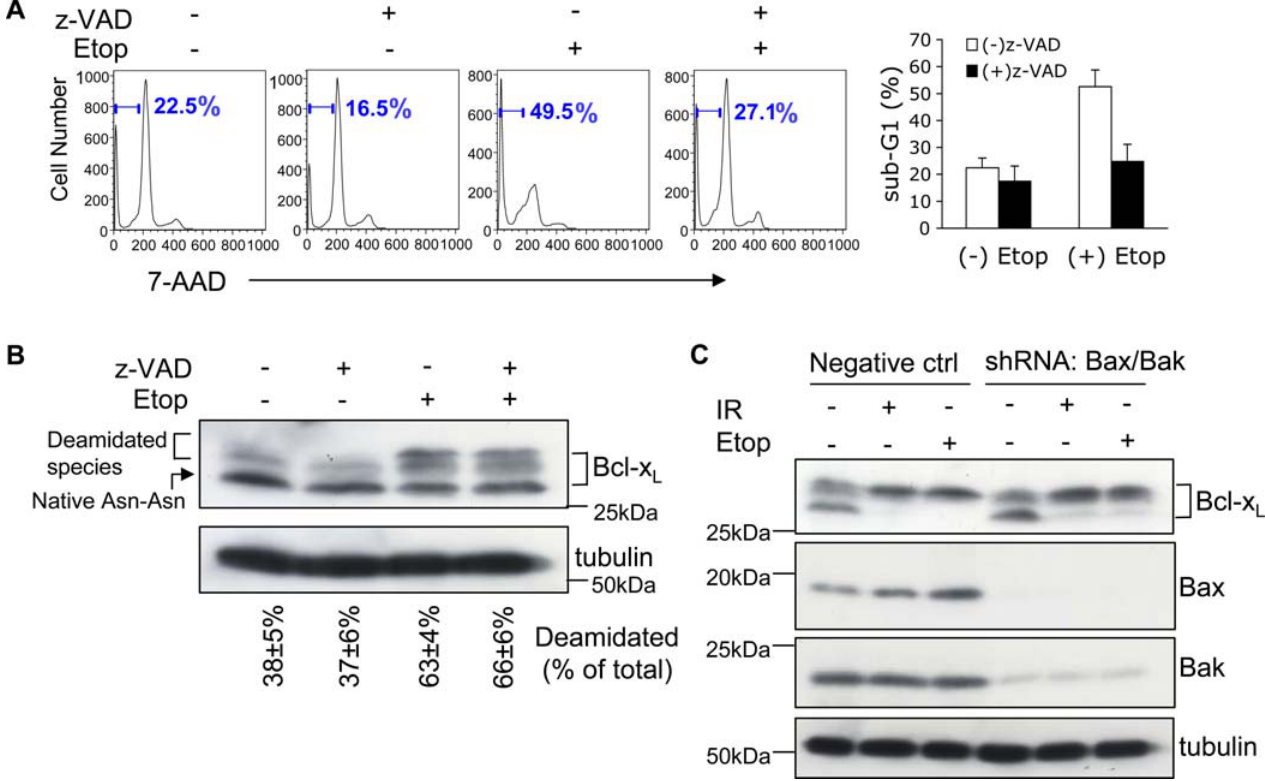
Figure 1. DNA Damage–Induced Bcl-x L Deamidation Is Mitochondrial Apoptosis–Independent (A) Wild-type thymocytes were pre-incubated with or without Z-VAD-fmk (200 l M), and were then cultured with or without etoposide for 24 h, harvested, and apoptosis was measured by measuring the sub-G1 peak by flow cytometry. The histograms (right panel) represent mean values 6 SD ( n ¼ 3). (B) Aliquots of the cells from (A) incubated in the presence or absence of Z-VAD-fmk (200 l M) were analysed for the expression of Bcl-x L and tubulin (as loading control) by immunoblotting. The upper and lower bands of Bcl-x L were quantified and expressed as a percentage of total Bcl-x L . The percentages shown below each lane are means 6 SD ( n ¼ 3). (C) Plasmids of shRNA Bax (GFP) and shRNA Bak (DsRed) were cotransfected into purified DN thymocytes using an Amaxa nucleofactor kit. 48 h